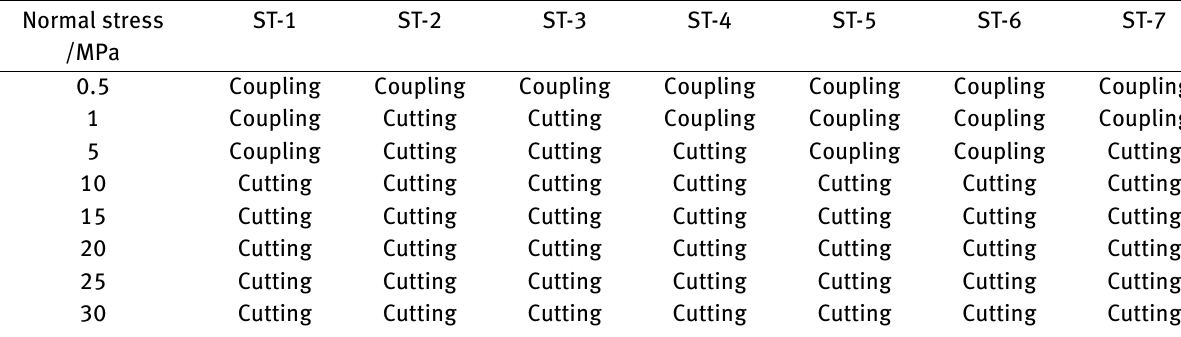
Table 4: Shear failure modes Normal stress